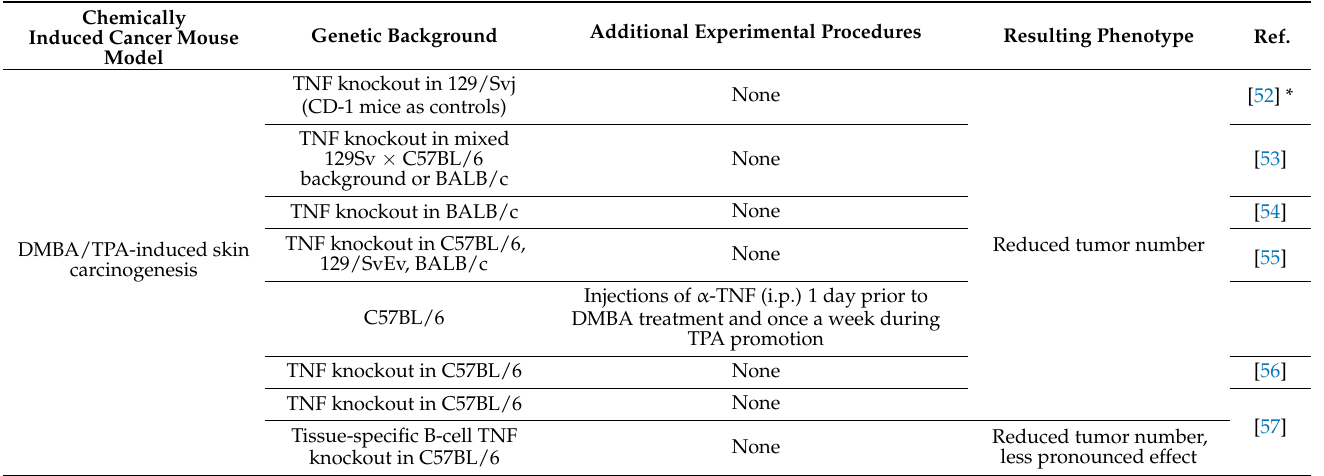
Table 2. Anti- and pro-tumorigenic effects of TNF and LT, as implicated by chemically induced mouse tumor models. Chemically Induced Cancer Mouse